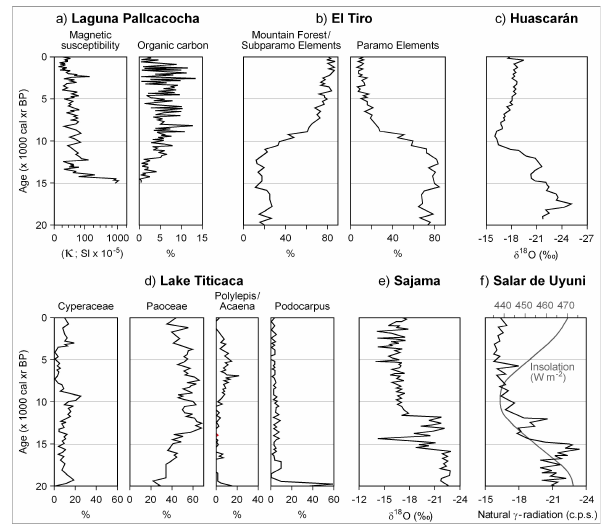
Fig. 3. Palaeoclimate data series from various proxy records for locations from the humid Andes (a–c) and the arid Andes (d–f) . Site locations are shown in Fig. 1. (a) Magnetic susceptibility and organic carbon in a sediment core from Laguna Pallcacocha, south- western Ecuador (from Rodbell et al., 1999, changed); (b) percent- age of pollen grains of mountain forest and subparamo elements versus paramo elements in a peat bog at El Tiro, southern Ecuador (from Niemann and Behling, 2007); (c) δ 18 O isotope record of the Huascar´an ice core (from Thompson et al., 2000, changed); (d) per- centage of pollen grains of various plant taxa from Lake Titicaca (from Paduano et al., 2003, changed); (e) δ 18 O isotope record of the Sajama ice core (from Thompson et al., 2000, changed); (f) natural γ -radiation of sediments from Salar de Uyuni and January palaeoinsolation at 15 ◦ S latitude (from Baker et al., 2001a; Berger and Loutre, 1991,